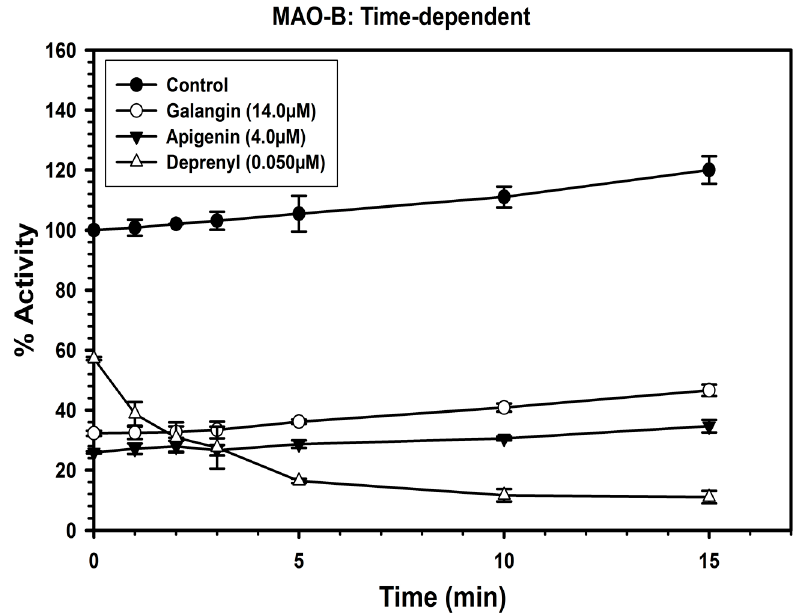
Figure 5. Time-dependent inhibition of recombinant human MAO-B by galangin (14.0 μ M), apigenin (4.0 μ M) and l-deprenyl (0.050 μ M). The remaining activity was expressed as % of activity. Each point represents mean ± S.D. of triplicate